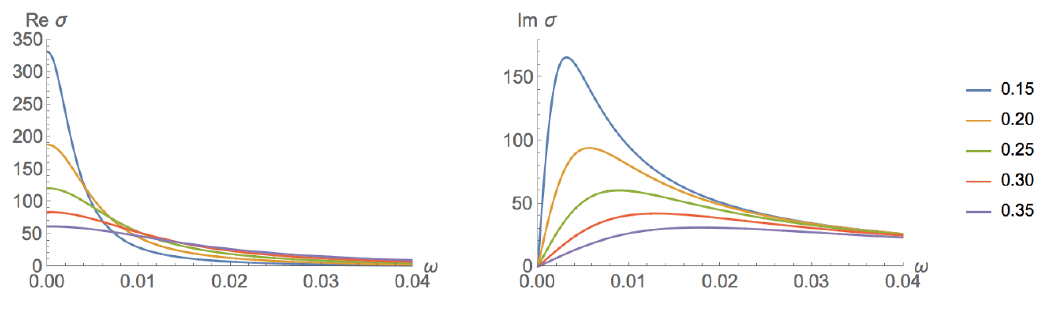
Figure 4 . Conductivity for ~q = 0. The colour coding corresponds to di(cid:11)erent values of the lattice amplitude A 0